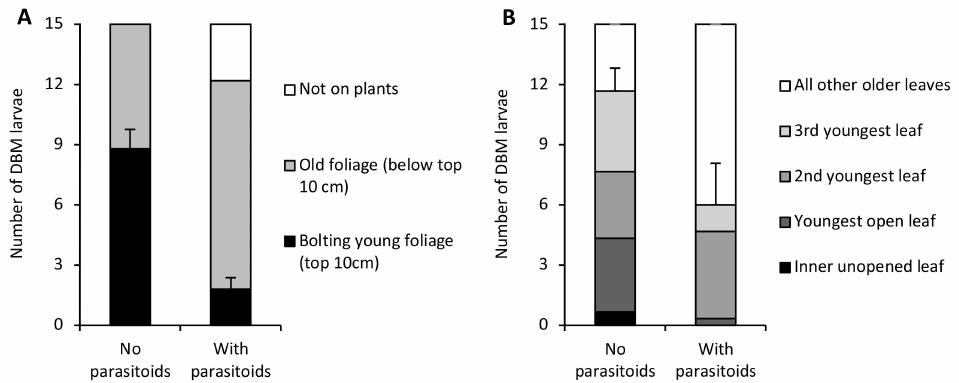
Figure 2. Differences in the location of diamondback moth larvae inside ( A ) Virginia pepperweed (VPW) and ( B ) cabbage enclosures in the absence and presence of parasitoids. Standard error bars are for mean numbers of larvae found on the bolting young foliage of Virginia pepperweed and the mean of the sum of larvae on the innermost unopened and three youngest opened leaves of